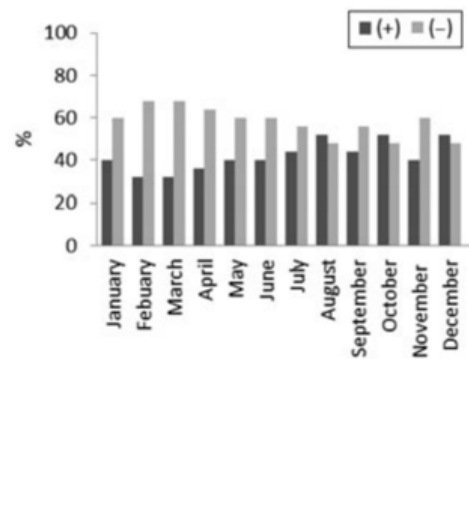
Fig. 2. Trends in time and space considered separa- tely: (A) location as a grouping factor (Wang et al., 2021) (B) time as a grouping factor (on the x-axis percentage of locations: stations with a positive/ne- gative trend in a given month) (Muhire & Ahmed, 2015) (C) presentation of the calculated trend on a map (Gupta et al.,